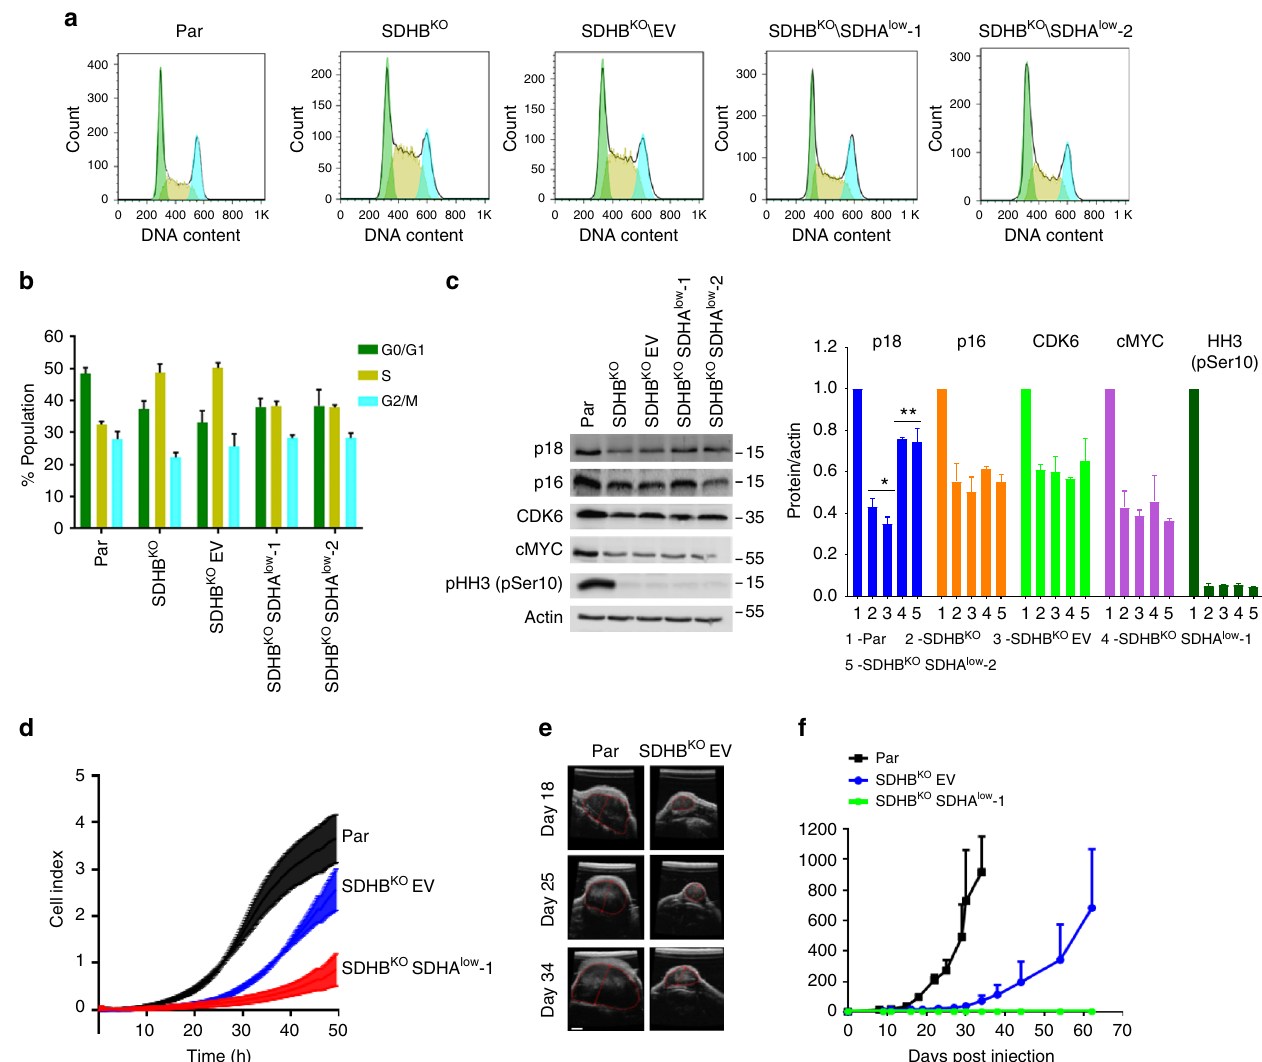
Fig. 5 CII low supports growth of SDHB-de fi cient tumors. a MDA231 sublines were evaluated for cell cycle distribution using fl ow cytometry and staining with propidium iodide. Green color indicates cells in G0/G1 phase, yellow cells in S phase, and blue color cells in G2/M phase. b Histograms show evaluation of data in panel ( a ) representing 10 4 cells. c SDS-PAGE followed by WB analysis of proteins linked to the regulation of cell cycle progression and mitosis; images are representative of three independent experiments. d MDA231 sublines were assessed for migration capacity using the xCELLigence system. e MDA231 sublines were grafted in Balb-c nu/nu mice at 10 6 cells per animal, and tumor progression was visualized and quanti fi ed by ultrasound imaging. The bar represents the size of 2 mm. f Representative images of tumors derived from parental and SDHB KO EV cells. Data shown are mean values ± SD ( n = 5 for b and c ). The symbol * indicates signi fi cant differences compared to parental cells with p < 0.05 and ** signi fi cant differences compared to SDHB KO cells with p < 0.05, as assessed by the two-tailed unpaired Student ’ s t